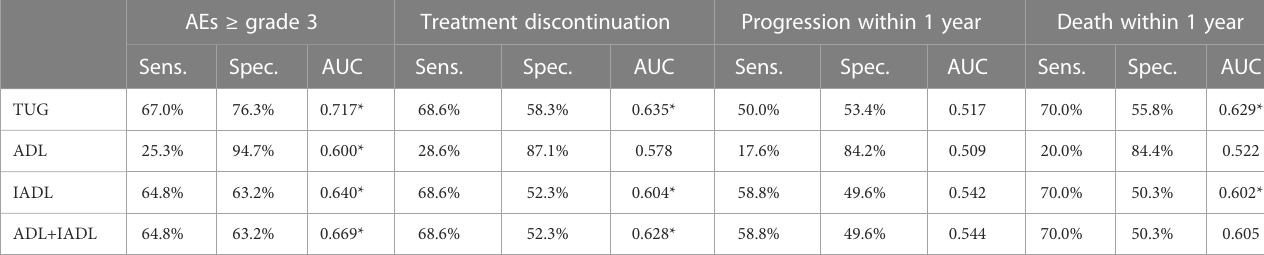
TABLE 4 Diagnostic value of functional status tools for AEs ≥ grade 3, treatment discontinuation, disease progression and death. AEs ≥ grade 3 Treatment discontinuation Progression within 1 year Sens.